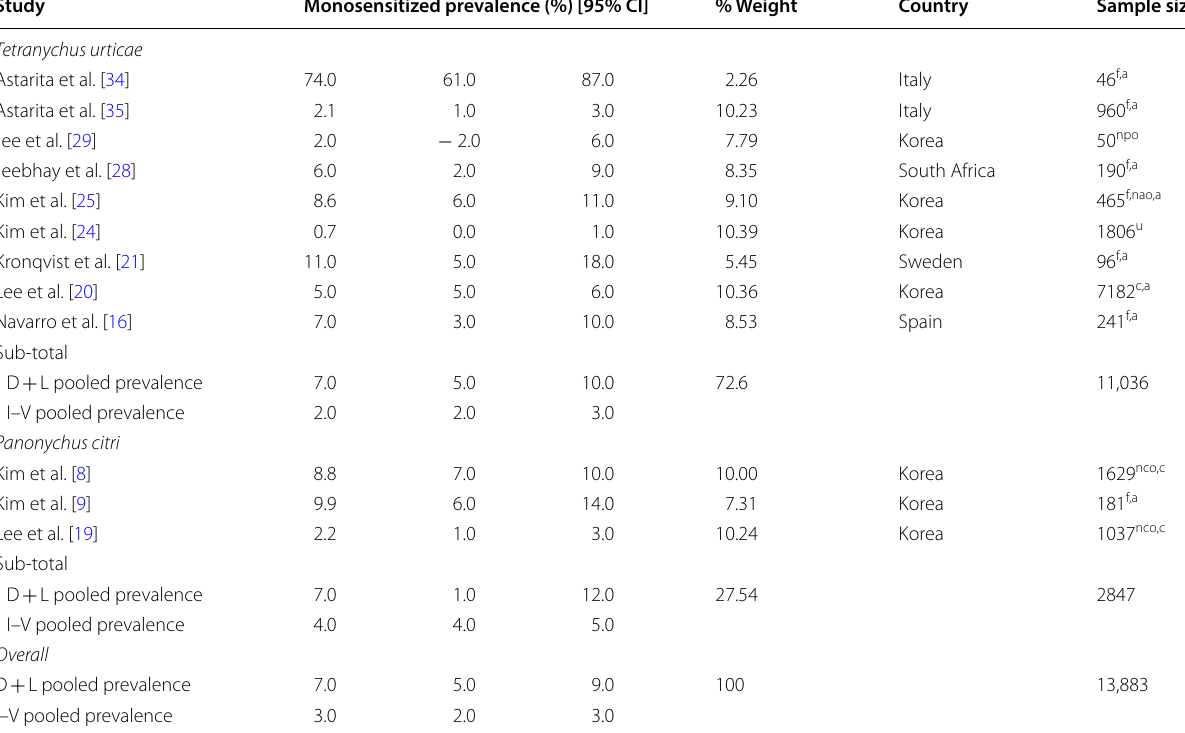
Table 4 Studies reporting